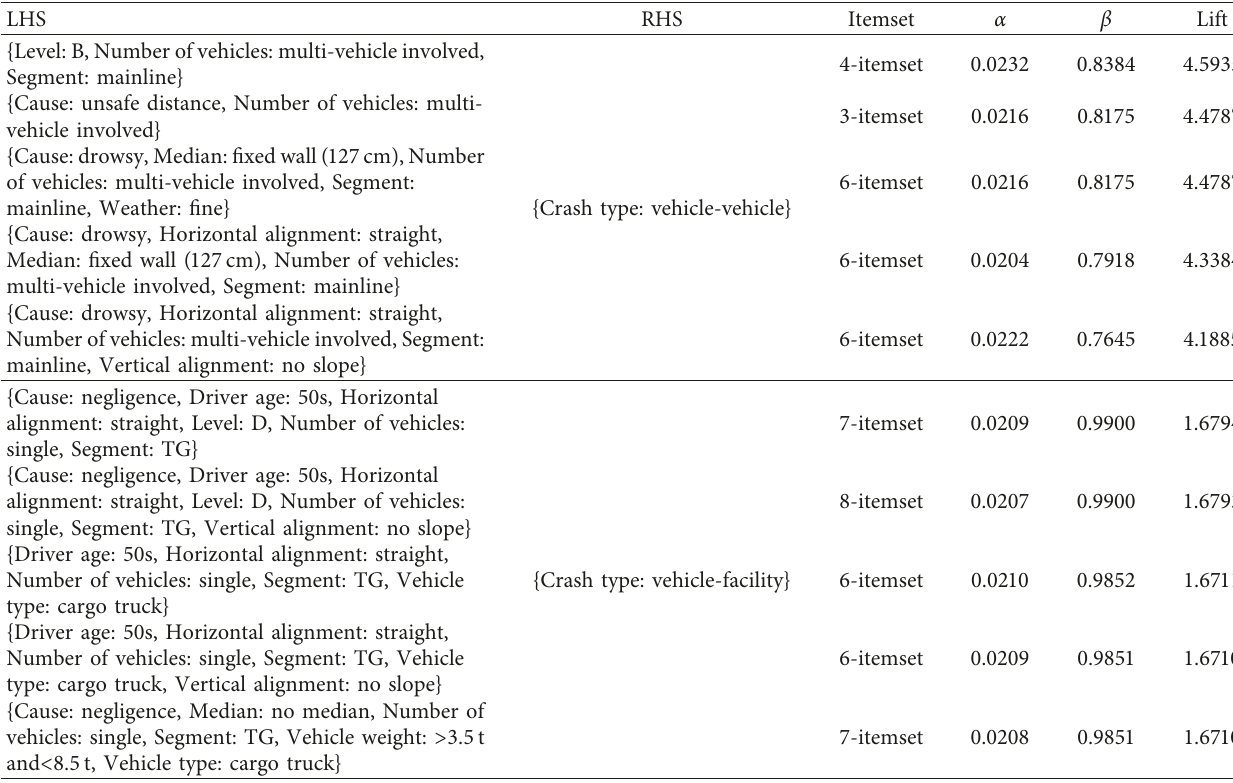
Table 7: Association rules by crash